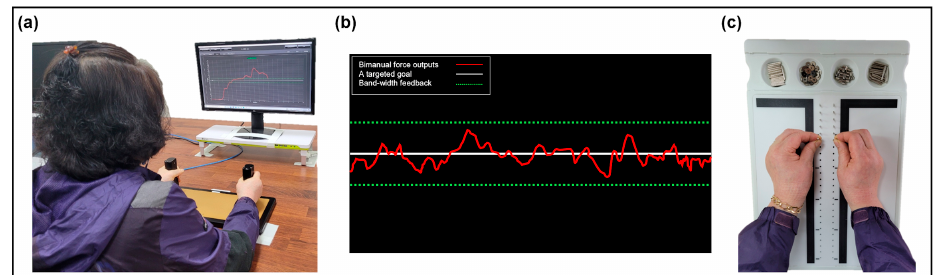
Figure 1. Experimental setup. ( a ) Isometric hand-grip force measurement systems to estimate bimanual MVC and submaximal force control capabilities. ( b ) Three types of visual feedback on the LED monitor. ( c ) Purdue Pegboard Test (PPT).